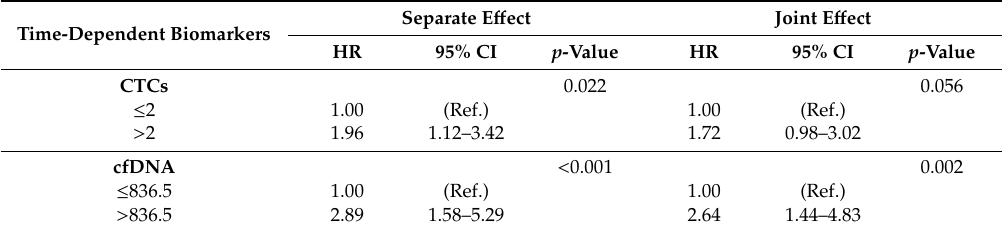
Table 2. Separate and joint prognostic e ff ect of repeated measurements over time of CTCs and cfDNA on OS estimated through the Cox regression